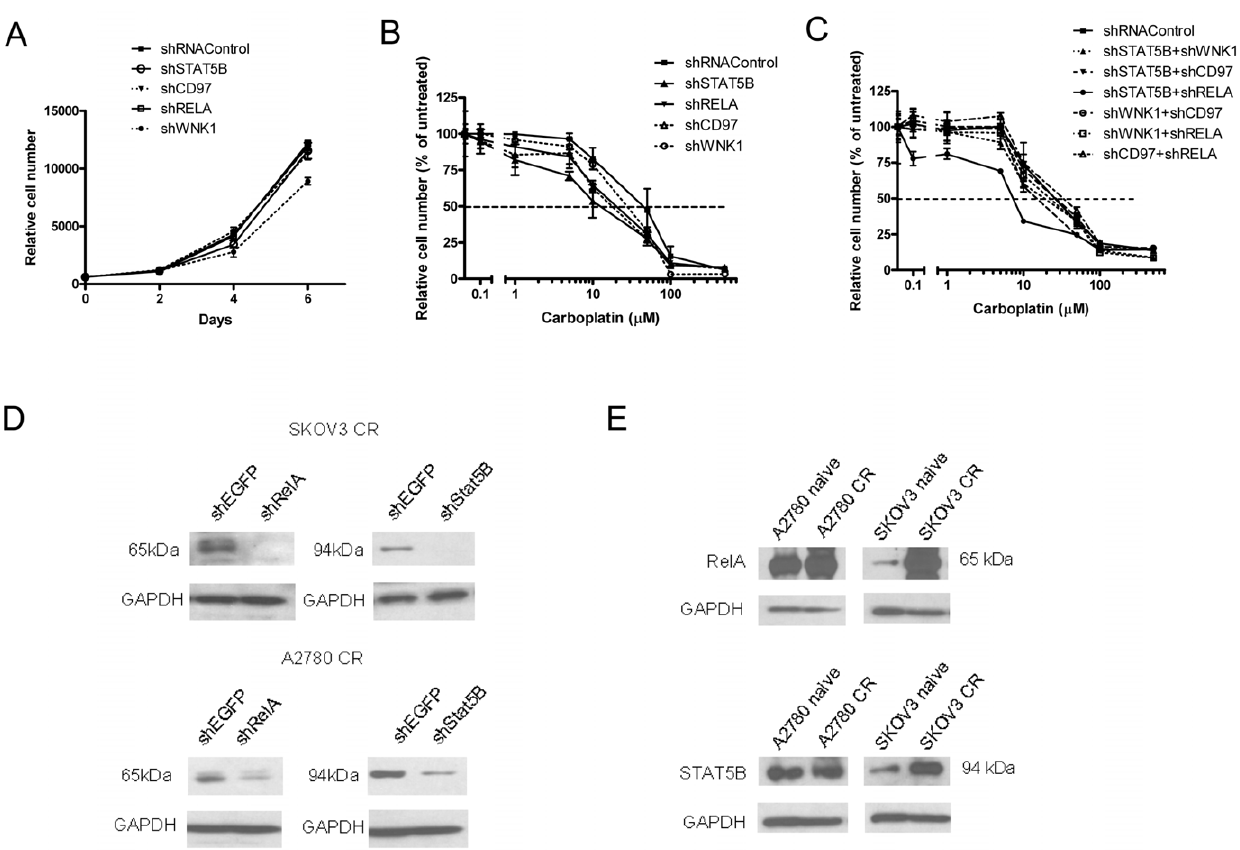
Figure 2. Identification of RELA and STAT5B as the major carboplatin-resistant genes in recurrent ovarian serous carcinoma. A) SKOV3 carboplatin-resistant cells (SKOV3-CR) were transfected with candidate gene-specific shRNAs, and cell growth was monitored for 6 days. B) SKOV3-CR cells were transfected with specific shRNAs against each candidate gene (STAT5B, WNK1, RELA, CD97), and selected with puromycin for 5– 7 days. The cells were then treated with various concentrations of carboplatin for 4 days, and the IC 50 was determined for each gene by cell viability assay. C) SKOV3-CR cells were co-transfected with combinations of two shRNAs against STAT5B, WNK1, RELA, CD97, and selected with puromycin for 5–7 days. The cells were then treated with various concentrations of carboplatin for 4 days, and IC 50 was determined for each gene by cell viability assay. D) Western blots showing reduced RELA and STAT5B expression 48 hours after transfection of their specific shRNAs in SKOV3-CR and A2780-CR cells. E) Western blots showing endogenous expression level of RELA and STAT5B in A2780 naı¨ve, A2780-CR, SKOV3 naı¨ve, and SKOV3-CR